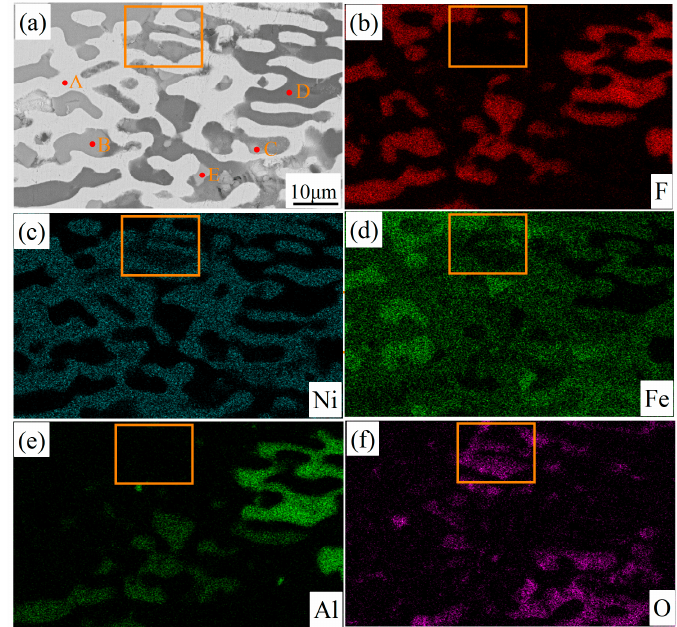
Metals 2019 , 9 , x FOR PEER REVIEW